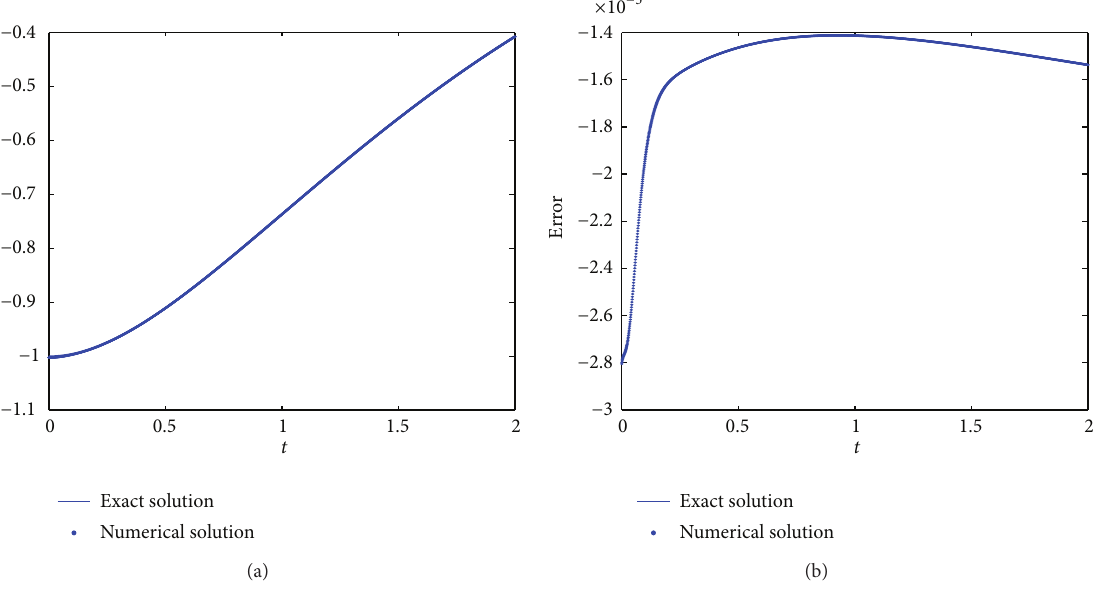
̂𝑓(𝑡) ̂𝑓(𝑡) (a), the error 𝑓(𝑡) − (b) with Δ𝑥 = 0.1 , Δ𝑡 = 0.001 .